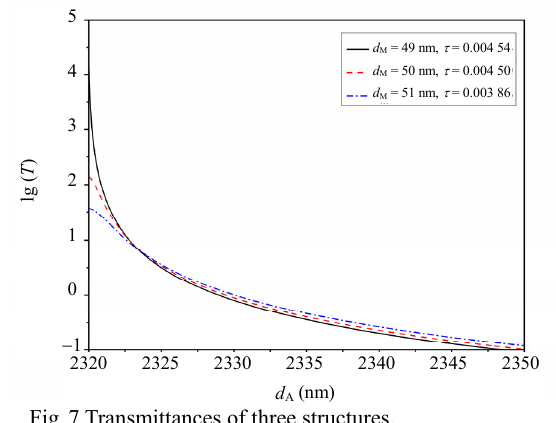
Fig. 7 Transmittances of three